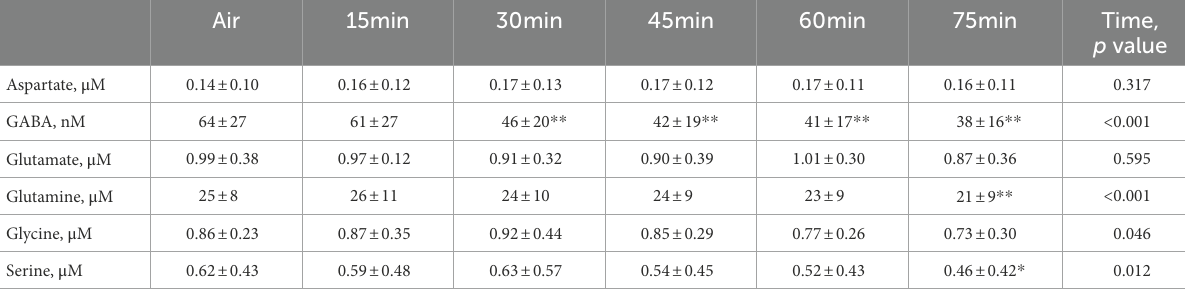
TABLE 1 Interstitial amino acids measured in the striatum of rats exposed to HBO 2 at 6 ATA.